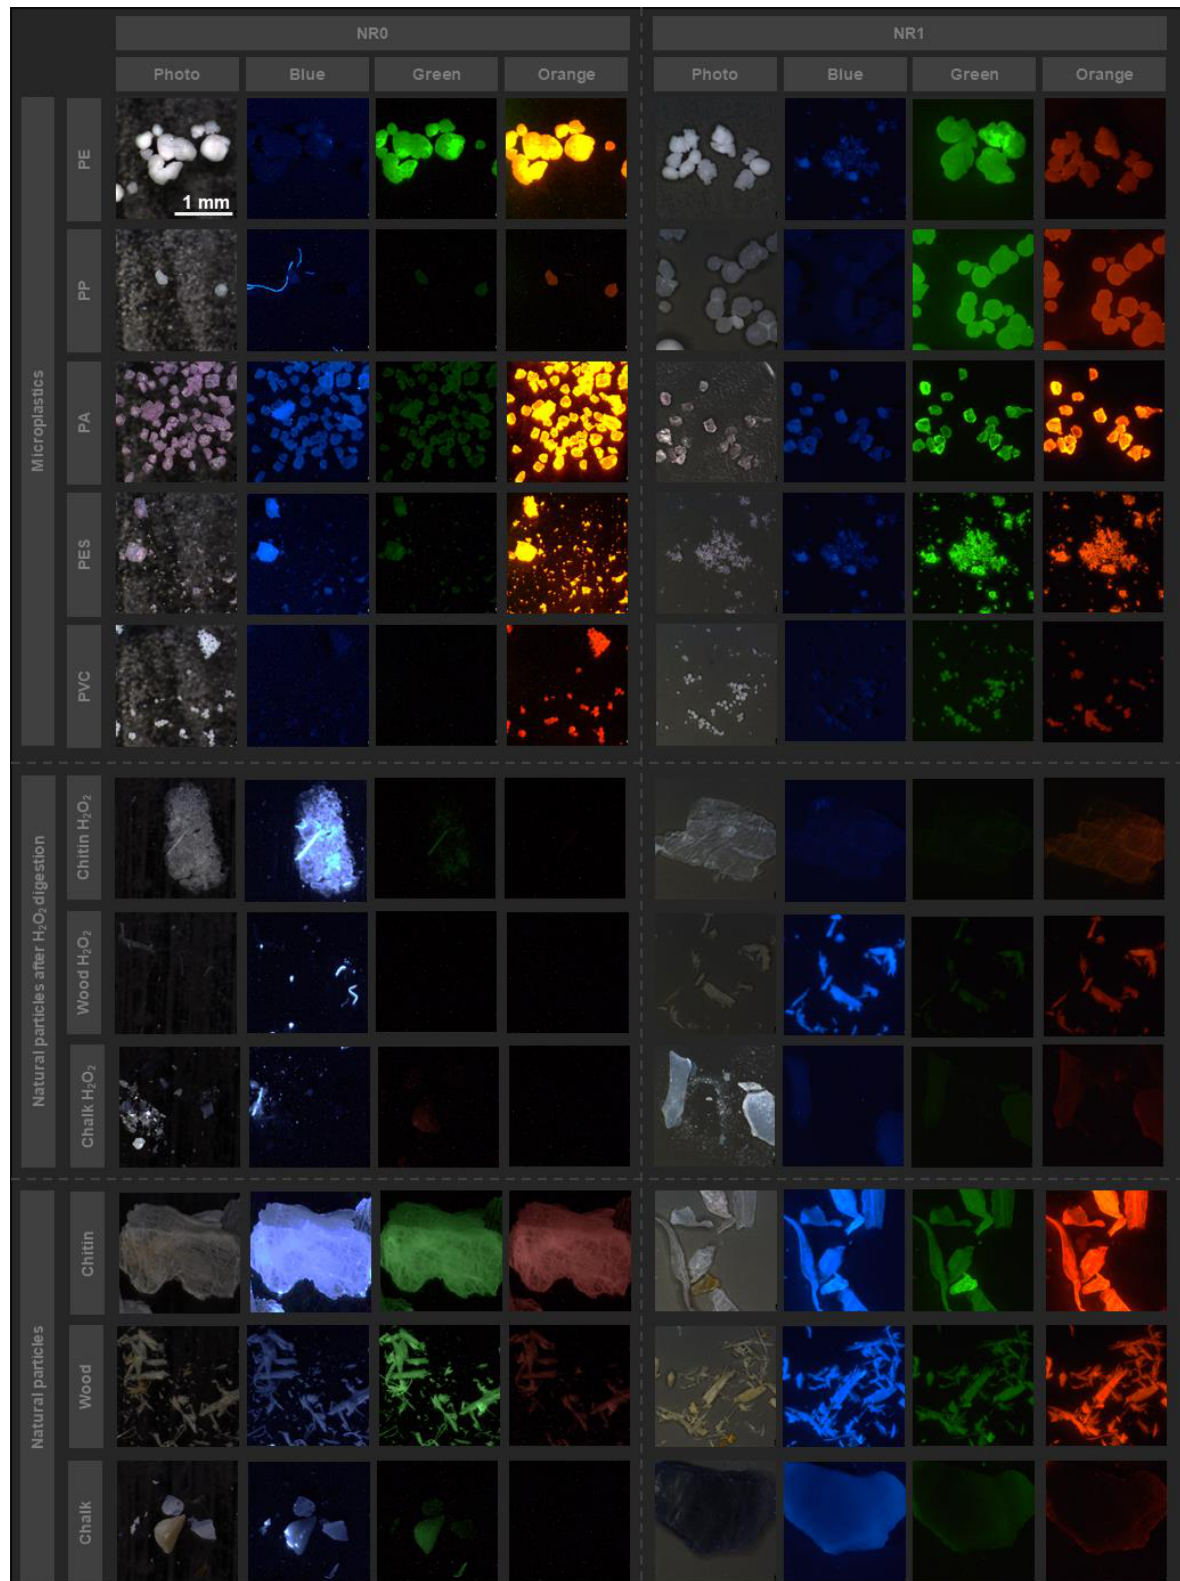
Figure 7. Fluorescent images of microplastics and natural particles stained with Nile red (NR0) and the new derivatives (NR1). Blue, green and orange fluorescence are compared. Additionally, the effect of the hydrogen peroxide treatment on the natural particles (see Section 2.4) is visualized.